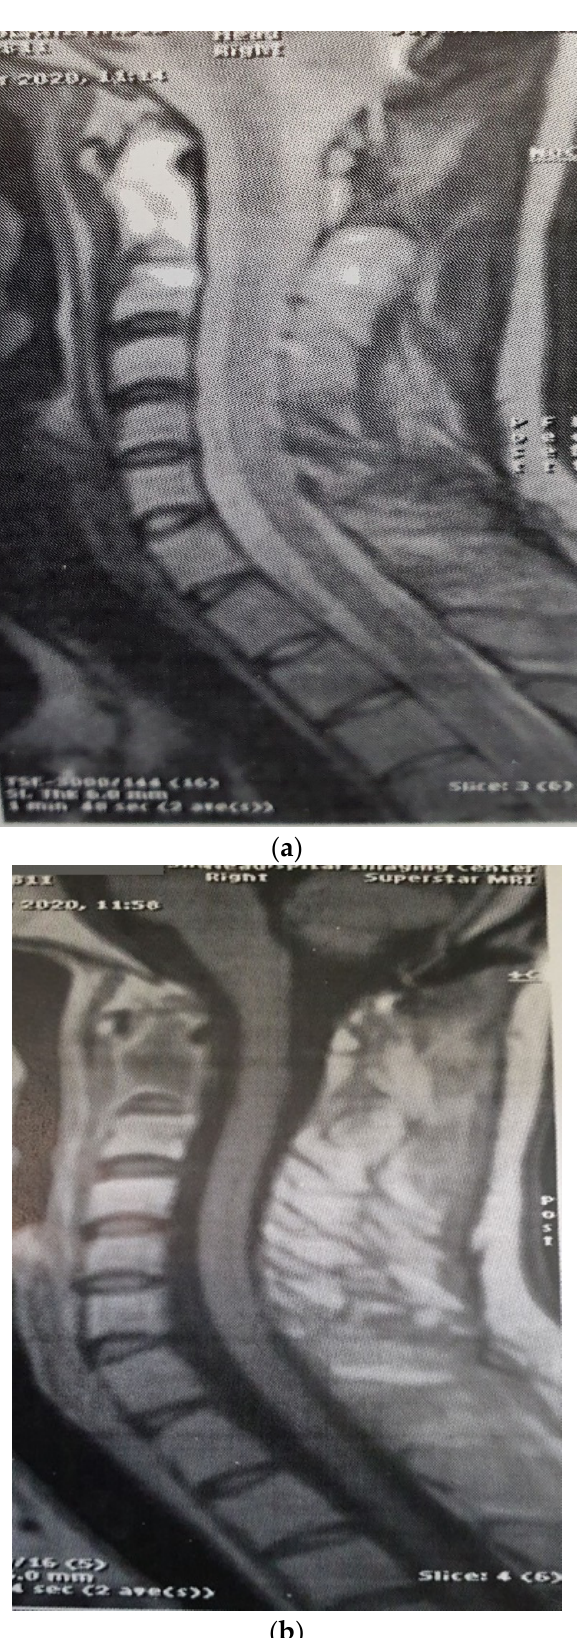
Figure 5. Post-radiotherapy MRI, sagittal T2W ( a ), sagittal T1W ( b ) showing a very good response to treatment.